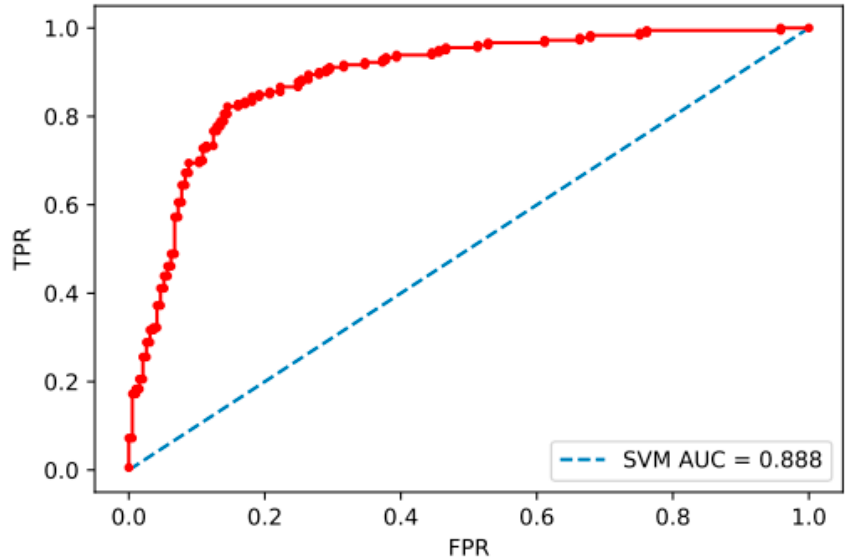
Figure 2. ROC curve of support vector machine model.